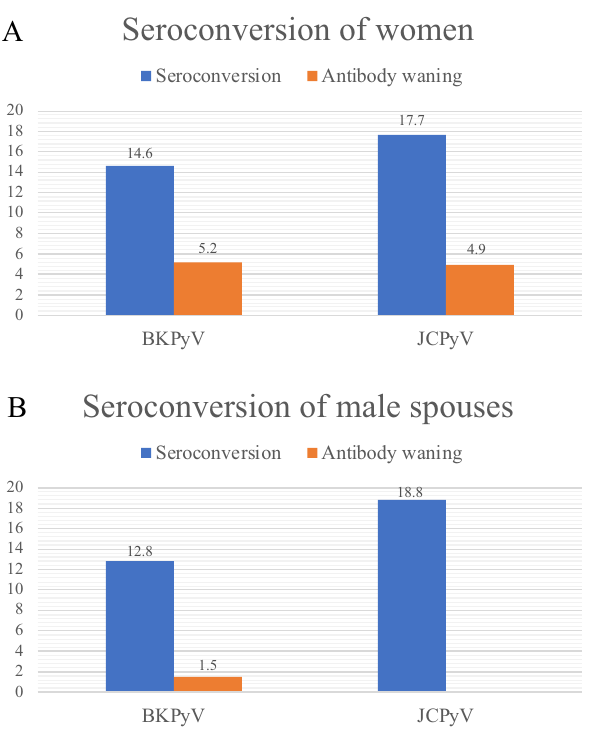
Figure 2. Proportion of the women ( A ) and their male spouses ( B ) who demonstrated BK (BKPyV) and JC (JCPyV) polyomavirus seroconversion or antibody waning during their 3-year follow-up. The number of women and their spouses who had BKPyV and JCPyV seroconversion were 48 and 58 and 17 and 25, respectively. The number of women and their spouses who had BKPyV and JCPyV antibody waning were 17 and 16 and 2 and 0,